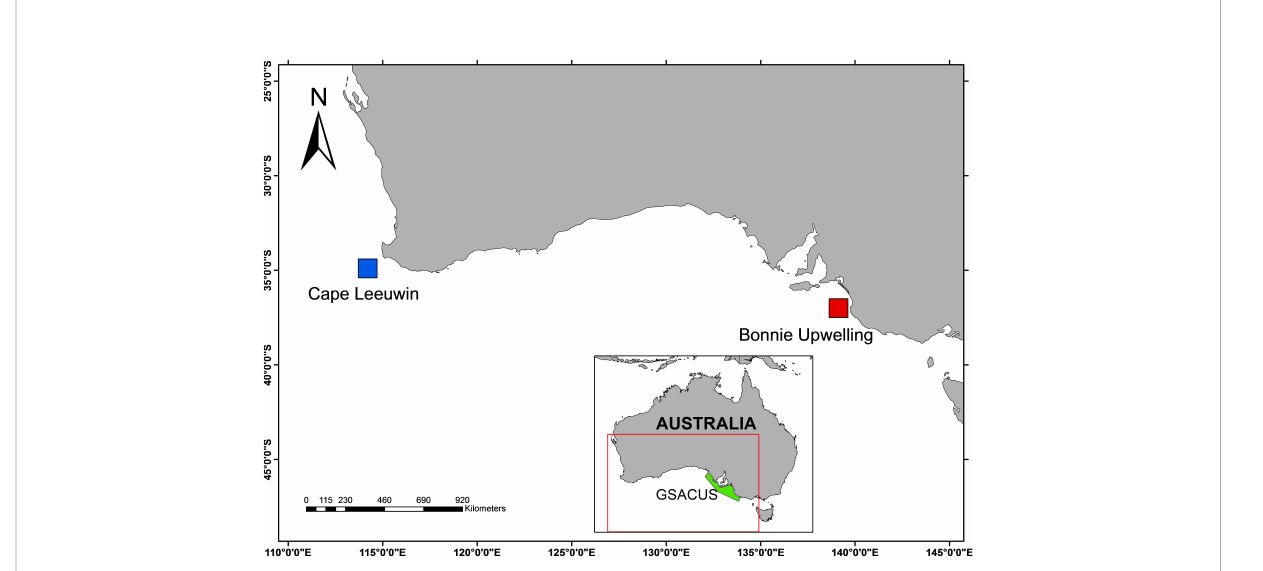
FIGURE 1 Map of the Australian Bight. The hydrophone H01W1 is located approximately 105 km from the shore at Cape Leeuwin, Western Australia (blue square). The Bonney Upwelling (red square) is the largest and most predictable upwelling location and also a known blue whale feeding aggregation area within the Great South Australian Coastal Upwelling System (GSACUS; highlighted in